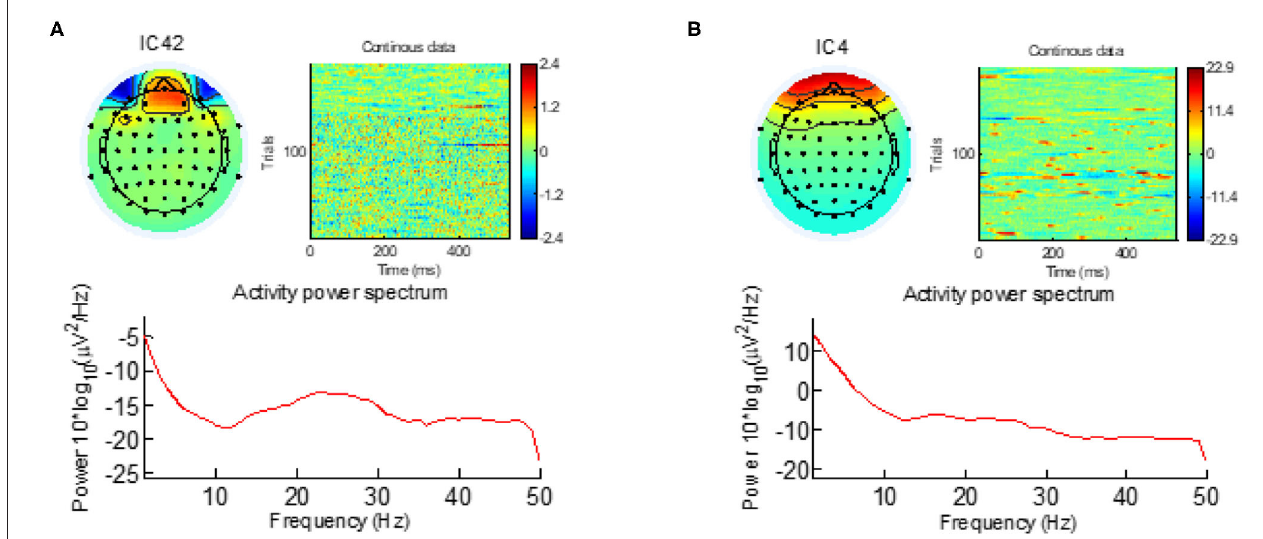
FIGURE 1 | The eye-blinking and eye-movement artifacts are visible both in the scalp map and in the activity power spectrum. (A) Eye-blinking artifact. (B) Eye-movement artifact.